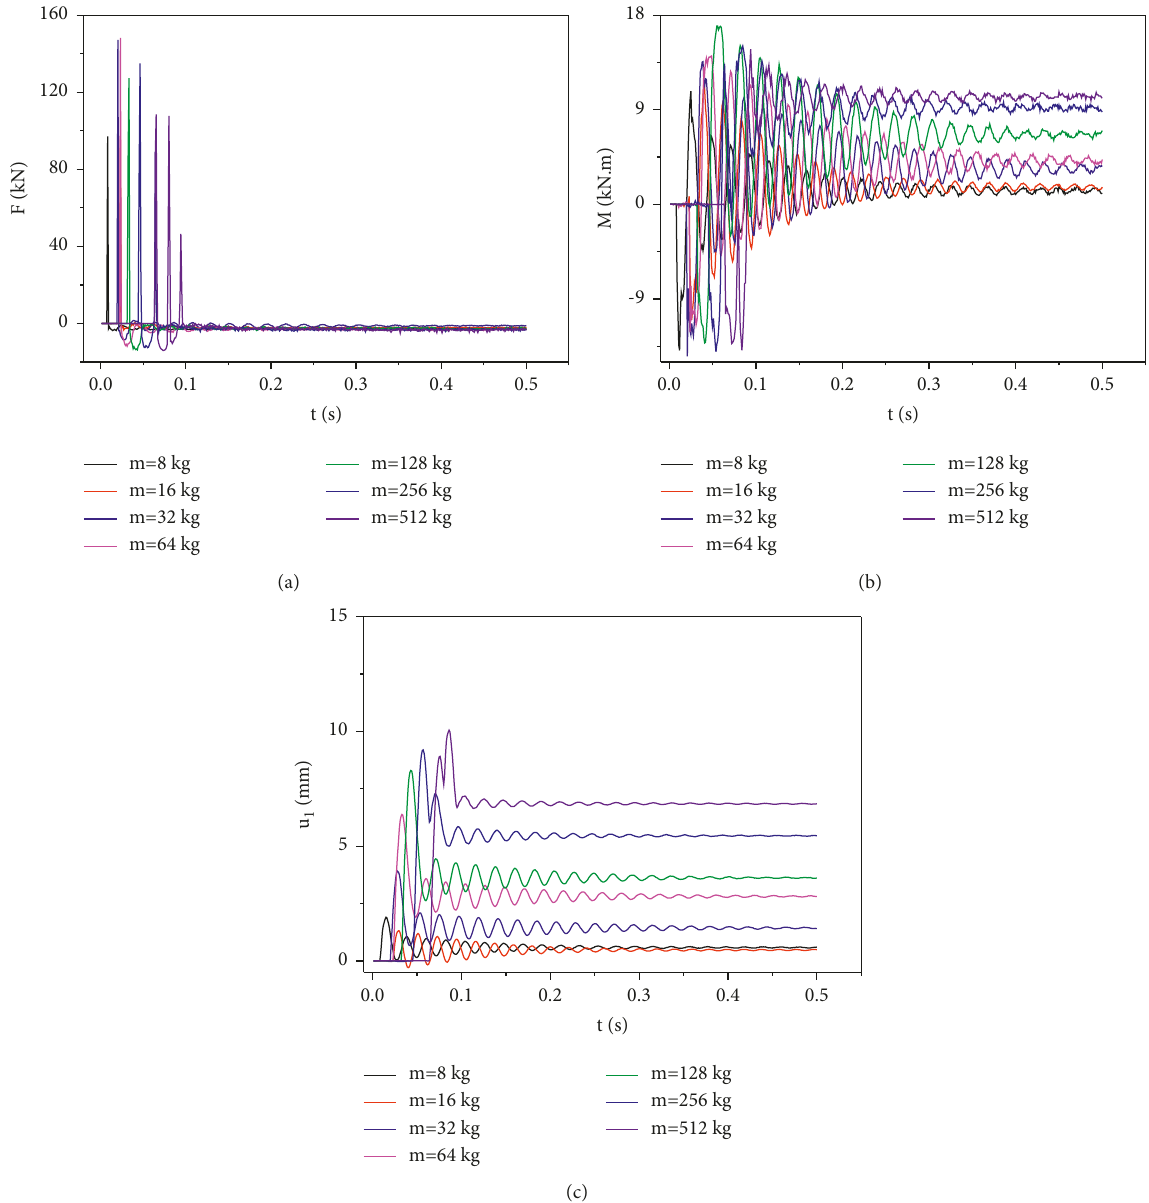
Figure 10: Dynamic response when Ek � 0.16kJ. (a) F- t ; (b) M- t ; (c) u1- t